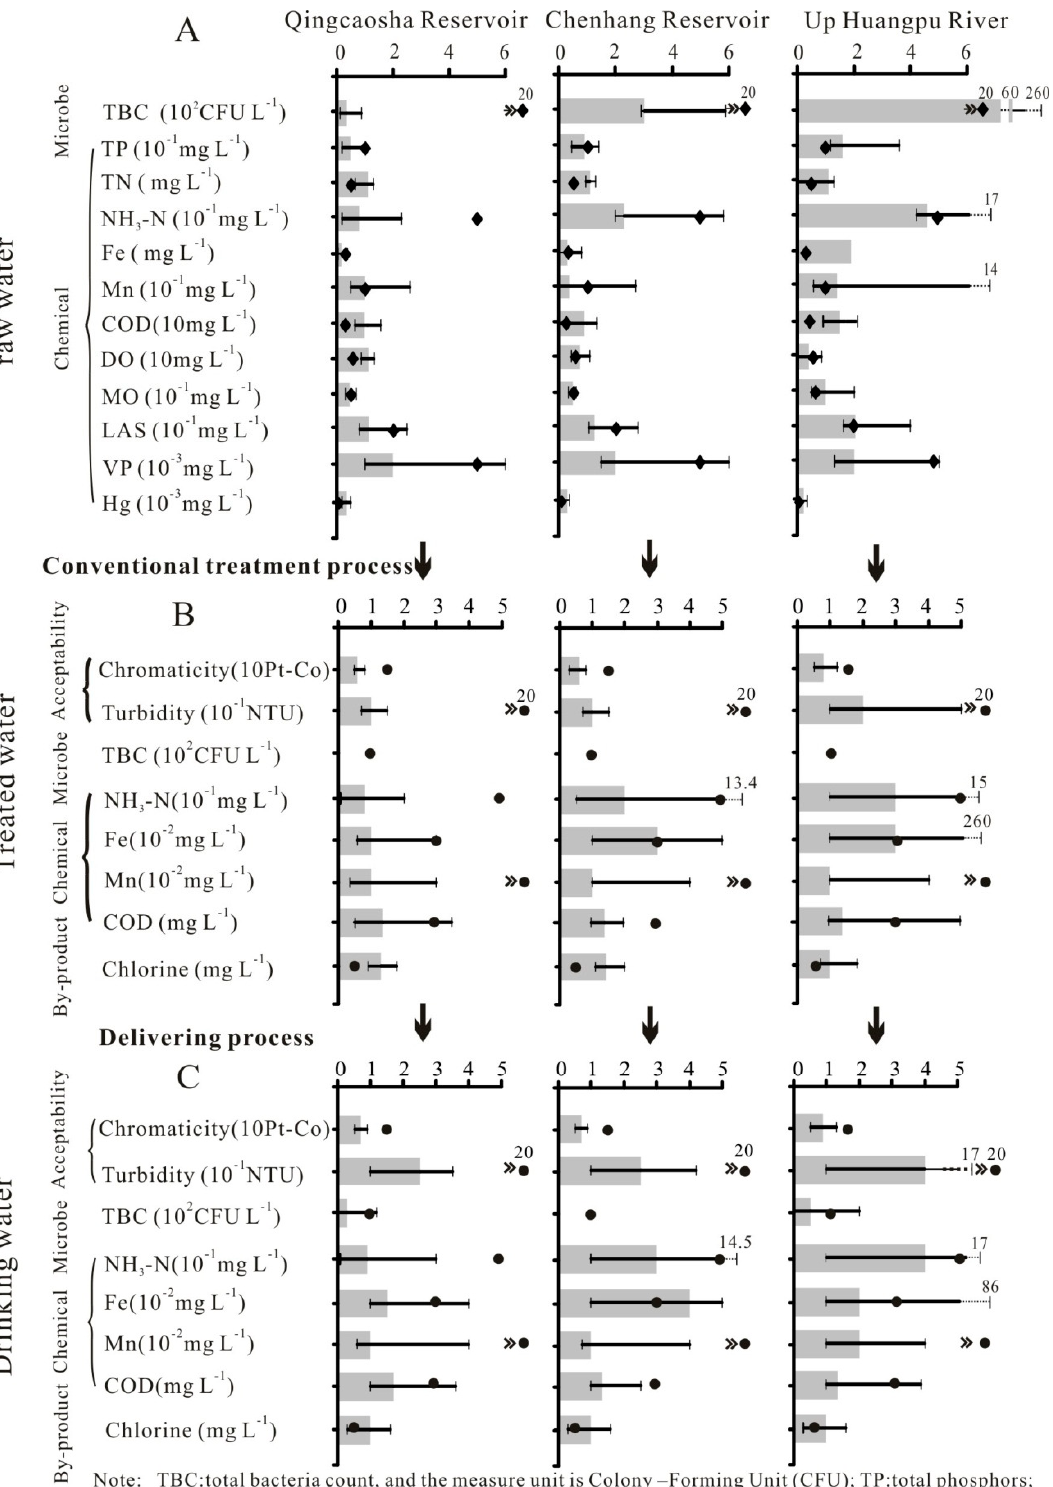
Figure 2. The quality of water from the Qingcaosha Reservoir, the Chenhang Reservoir and the Huangpu River as it proceeds from raw water ( A ) to treated water ( B ) and at its final delivery point ( C ).